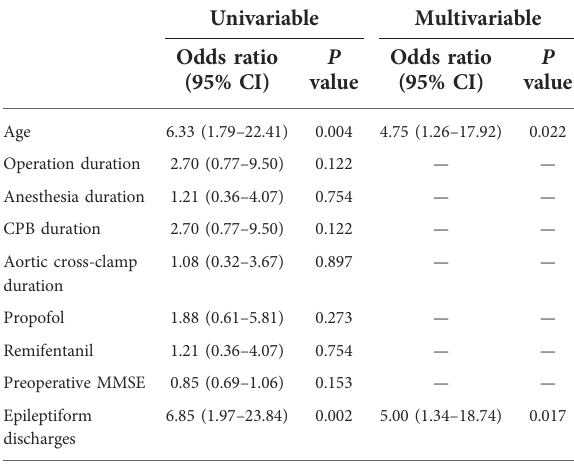
TABLE 2 Comparison between patients with and without epileptiform discharges.